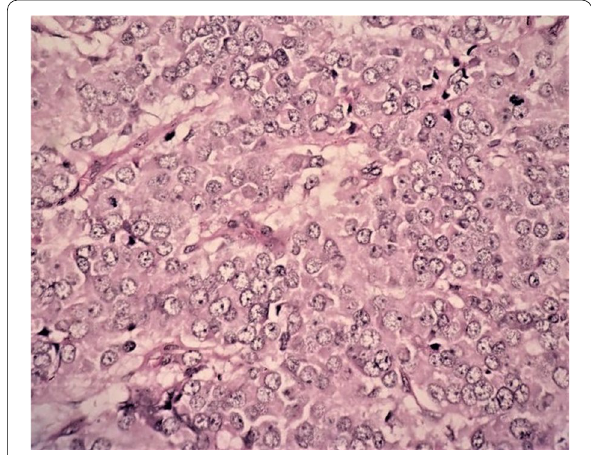
Fig. 1 Microscopic appearance of the deposit of the adenocarcinoma in excision biopsy of the cervical lymph node (H&E)